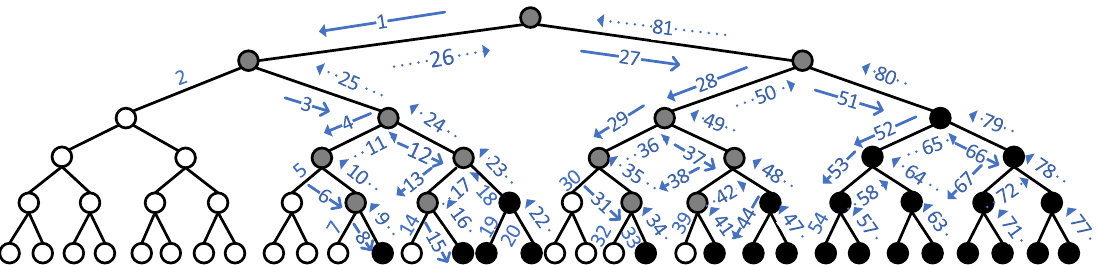
Figure 4. Schematic diagram of the SC decoding time step.